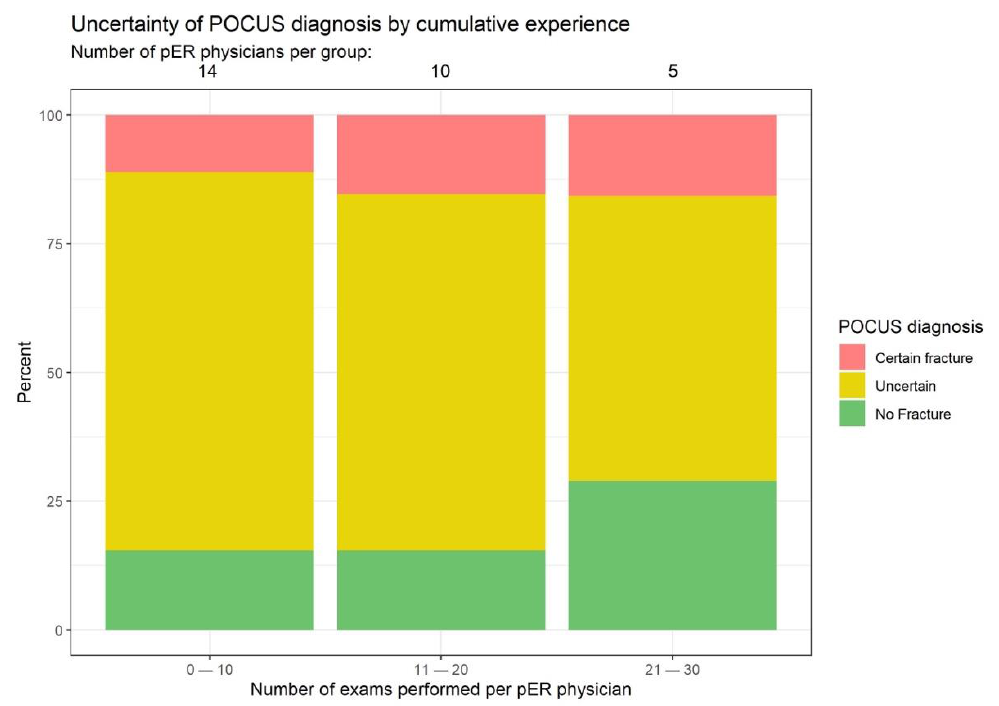
7 of 10 Figure 4. Time difference between ultrasound investigation and radiographic image study.